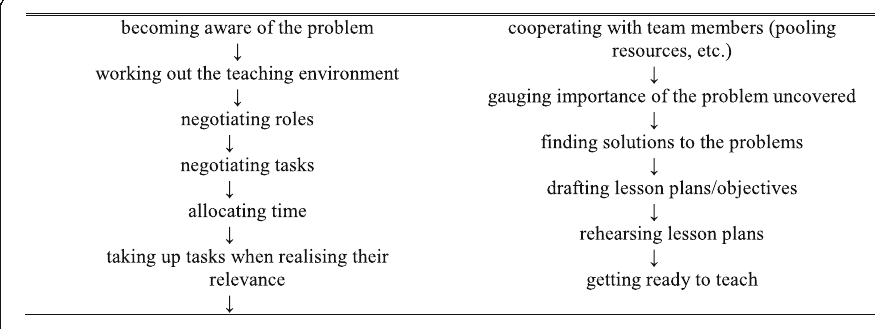
Fig. 1 Sequence of Thinking in Student teachers ’ Lesson Planning